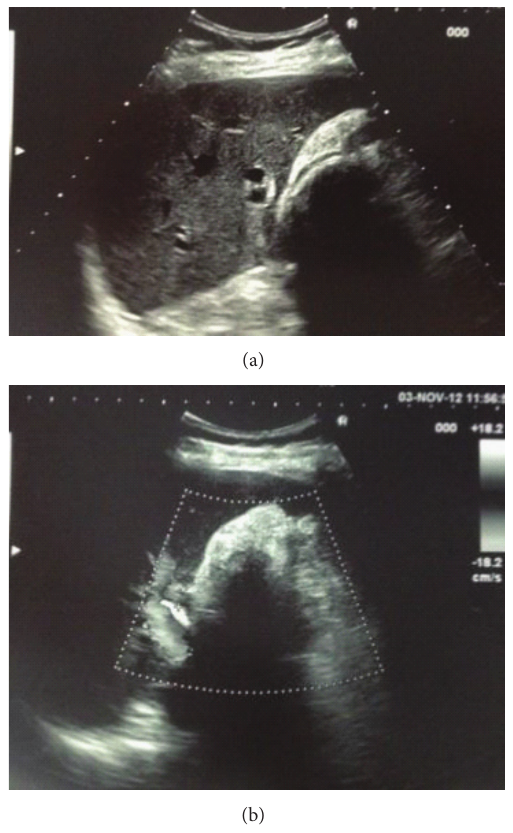
F 1: Abdominal ultrasound showing a gallbladder with thick walls and one large gallstone (50mm) entrapped into the Hartmann pouch.